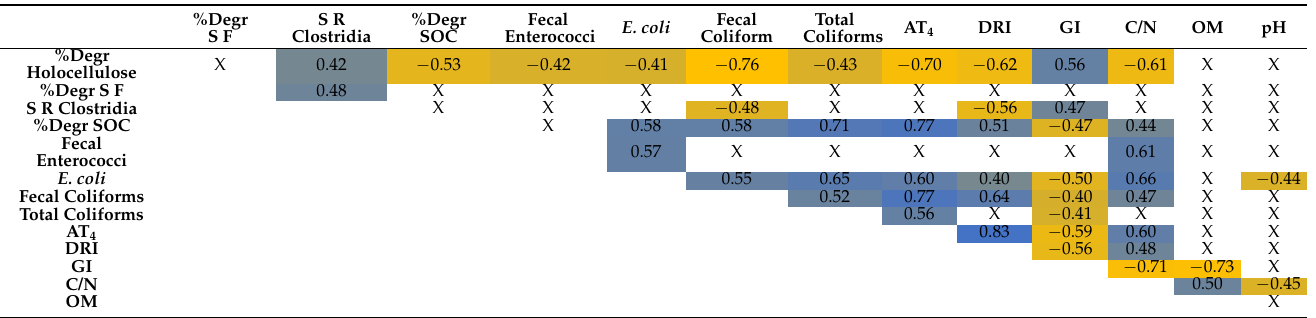
Table 4. Spearman’s correlation matrix between maturity indexes, physico-chemical parameters and microbiological contamination of industrial composts (n =